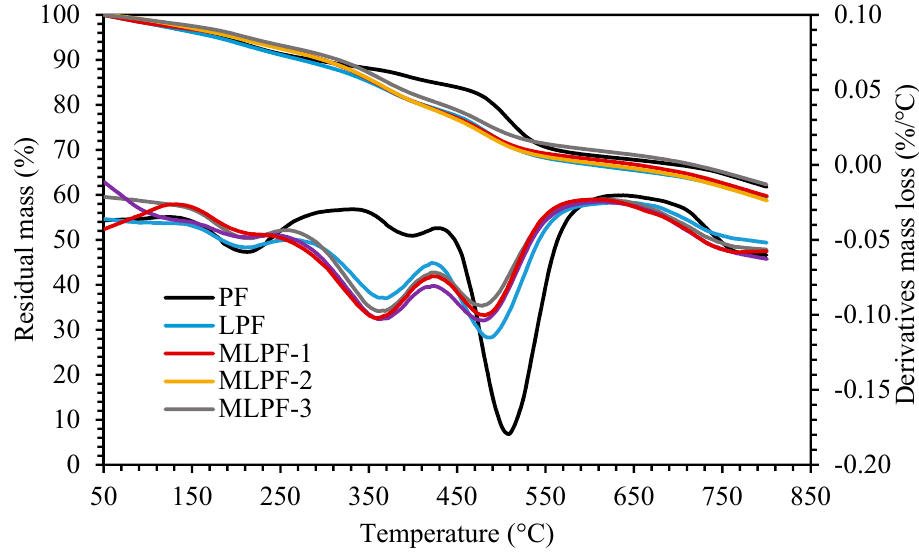
Figure 2. TGA and DTG profiles of the cured adhesives.